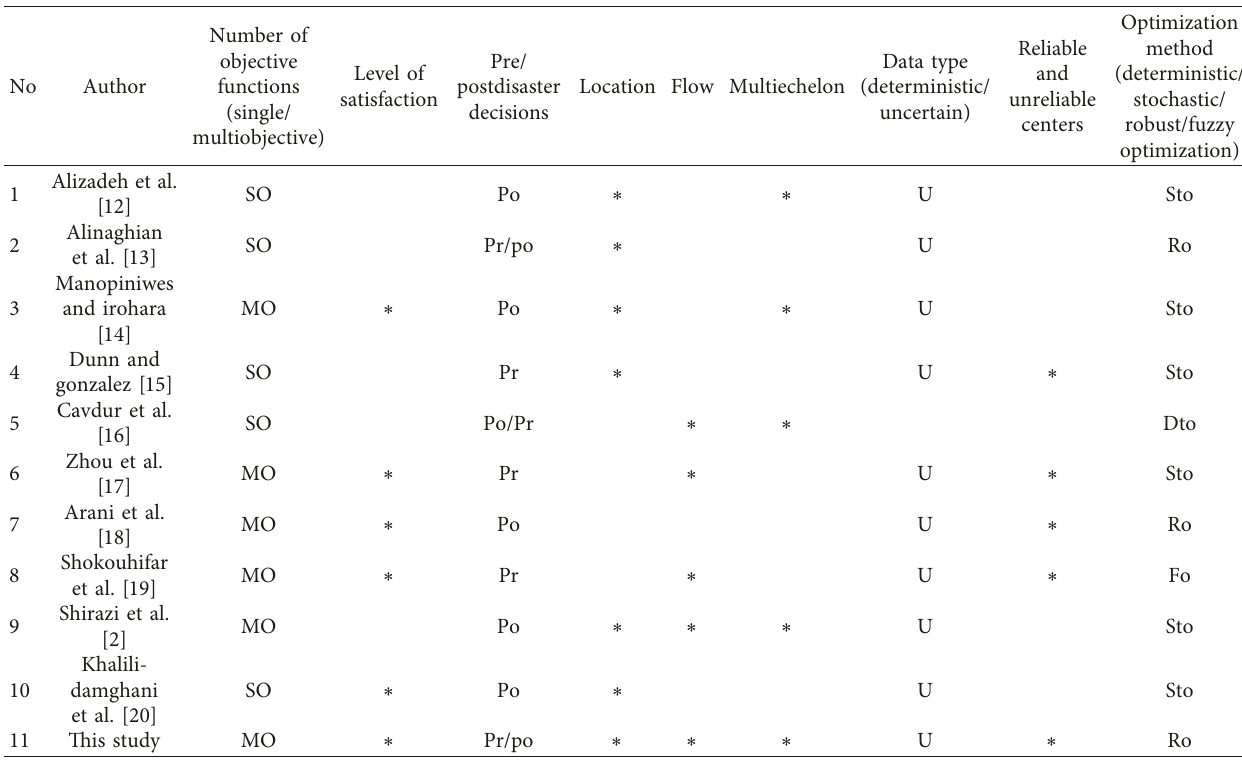
Table 1: Literature